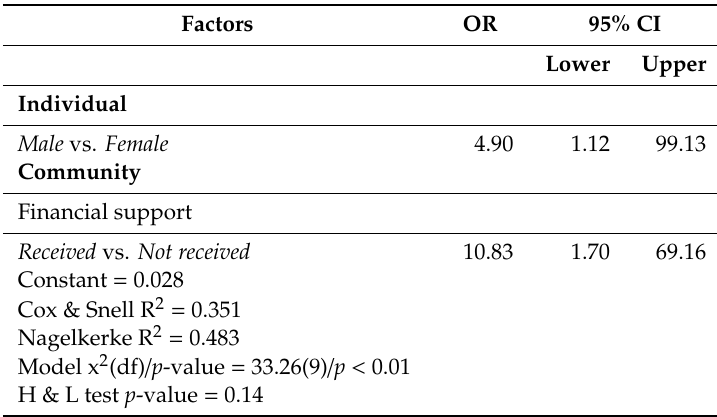
Table 4. Factors for predicting